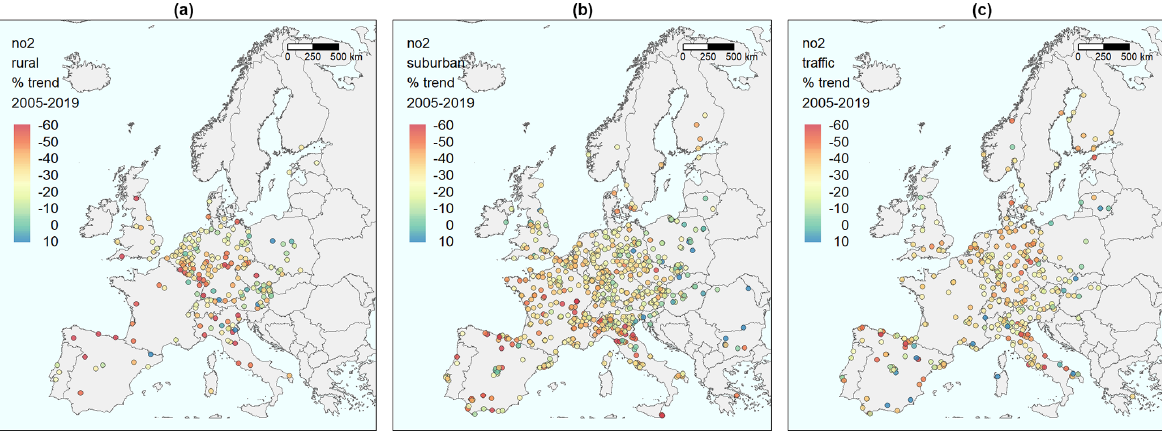
Figure 2. Maps of stations in Europe with the percentage change in expected concentrations from 2005 to 2019, relative to the initial level in 2005, based on the meteorology-adjusted trend for NO 2 . (a) Background stations in rural areas. (b) Background stations in urban/suburban areas. (c) Traffic